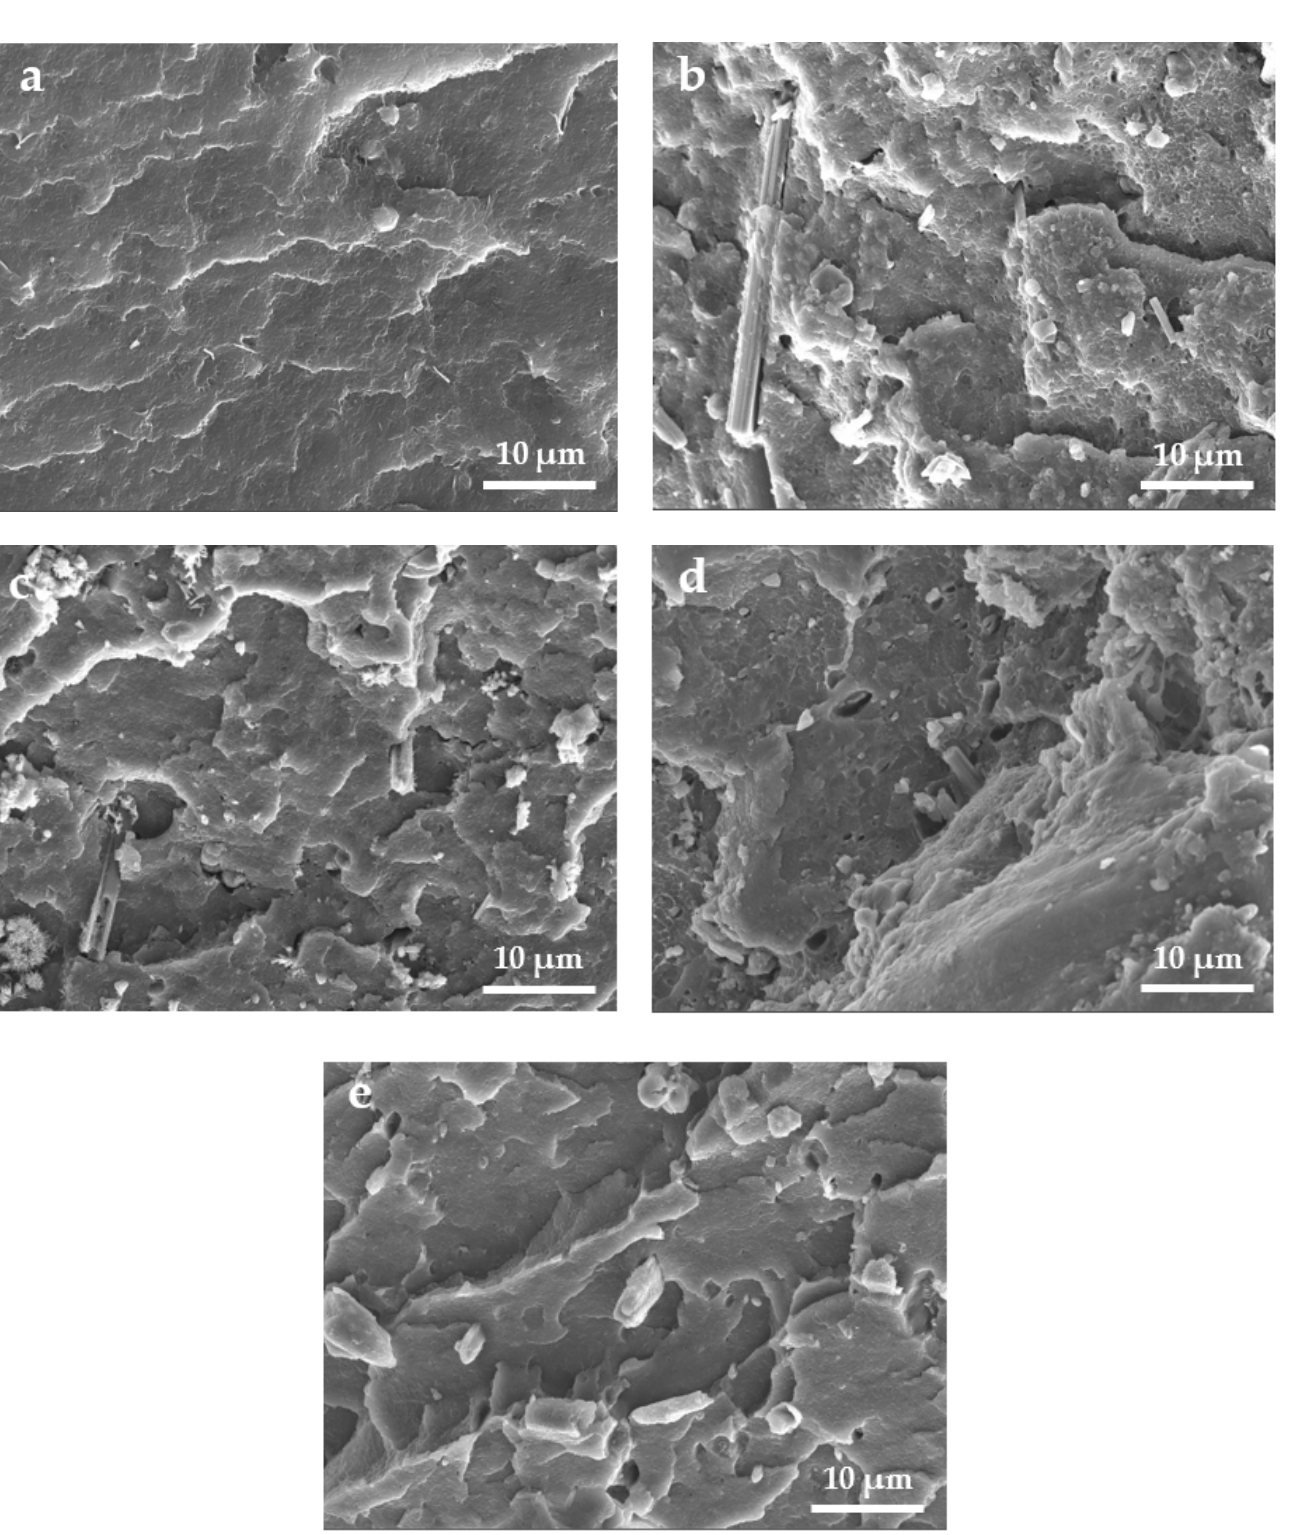
Figure 8. Section morphology of ( a ) pure PVC, ( b ) untreated CSW/PVC, ( c ) CSW-OH/PVC, ( d ) CSW- OH-KH570/PVC, and ( e ) CSW-g-PMMA/PVC. ( d ) CSW-OH-KH570/PVC, and ( e )